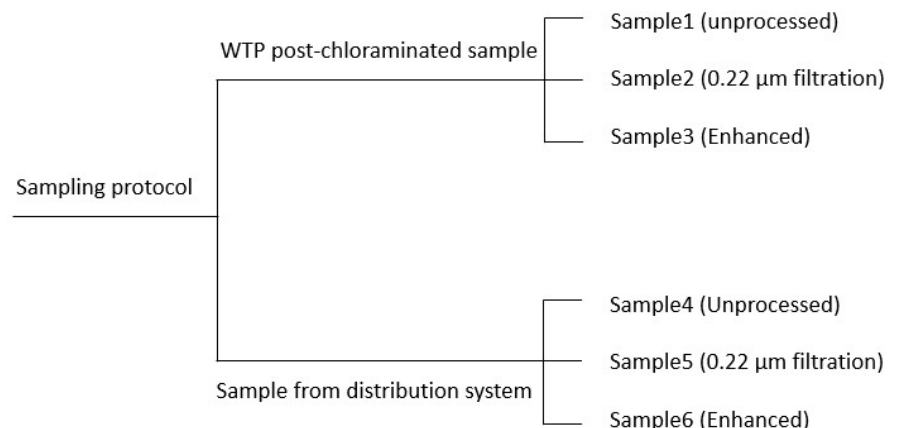
Figure 1. Framework of the study. The blue and red colors represent individual experiments related to monochloramine and NO x − ,respectively.